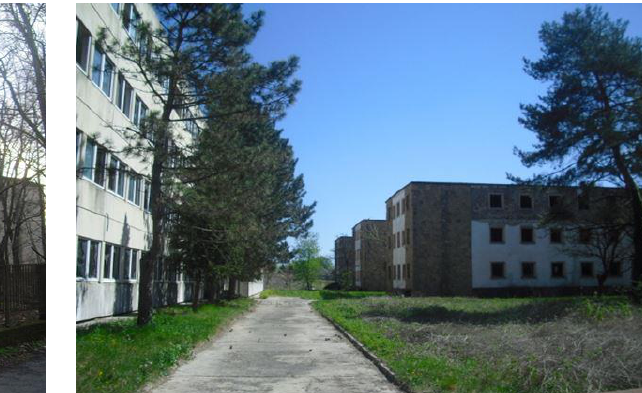
Fig. 17. Újpest, Sándor Petőfi Barracks Fig. 18. Újpest, István Dobó